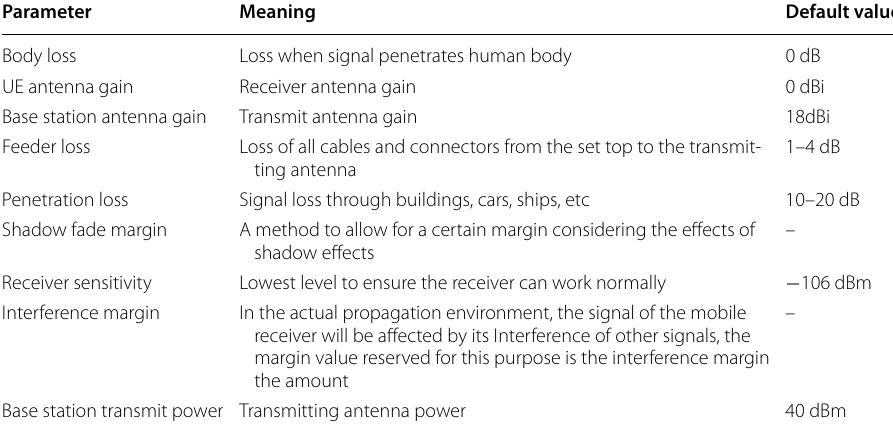
Table 3 Meaning of each parameter of the downlink Parameter Meaning